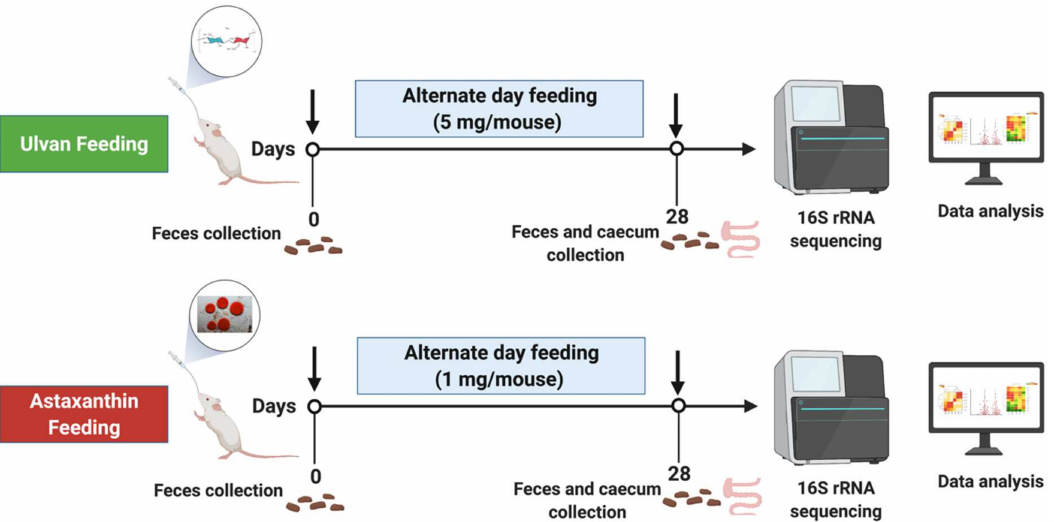
Figure 1. Feeding of ulvan and astaxanthin to BALB/c mice. Timeline depicting the feeding regimen of ulvan and astaxanthin on alternate days for 28 days. Feces pellets were collected on Day 0 and Day 28 and caecum samples on Day 28 and analyzed for the